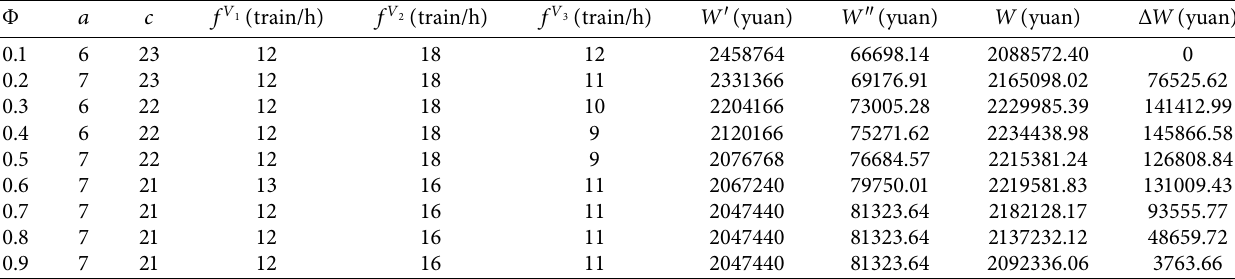
Table 5: Influence analyses of weight setting on computing results.